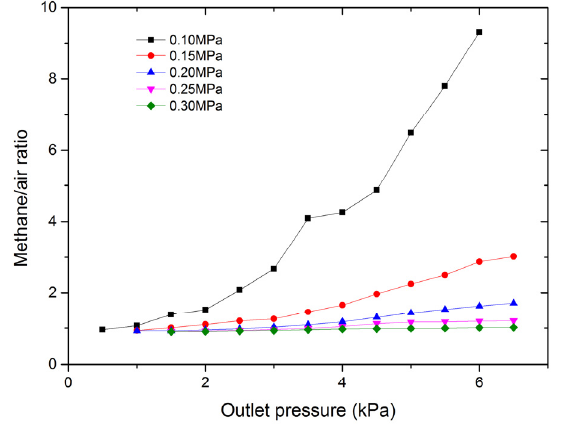
Figure 7. Methane/air ratio as the function of inlet and outlet pressure of the